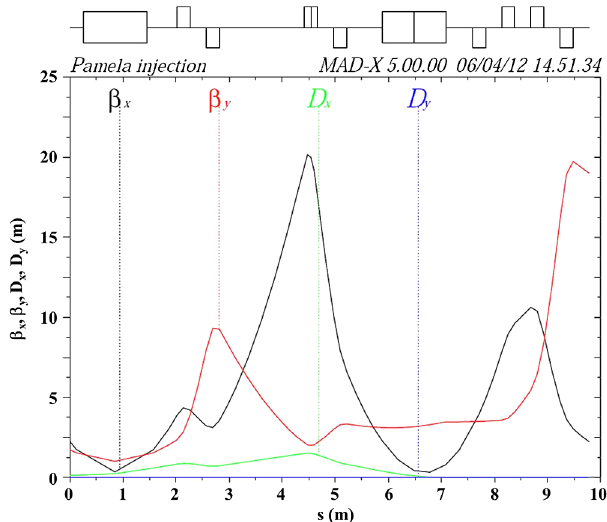
FIG. 32. Beta functions and dispersion for the proton line shown in Fig. 31. The optics is shown in the inverse configura- tion, which means that the cyclotron is located on the right and the FFAG cells are located on the left.